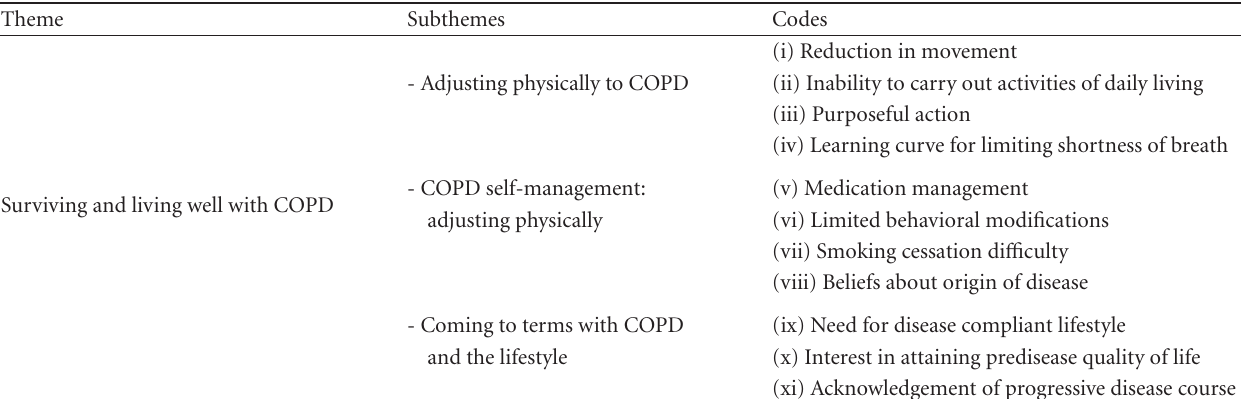
Table 2: Theme and subthemes for data and associated